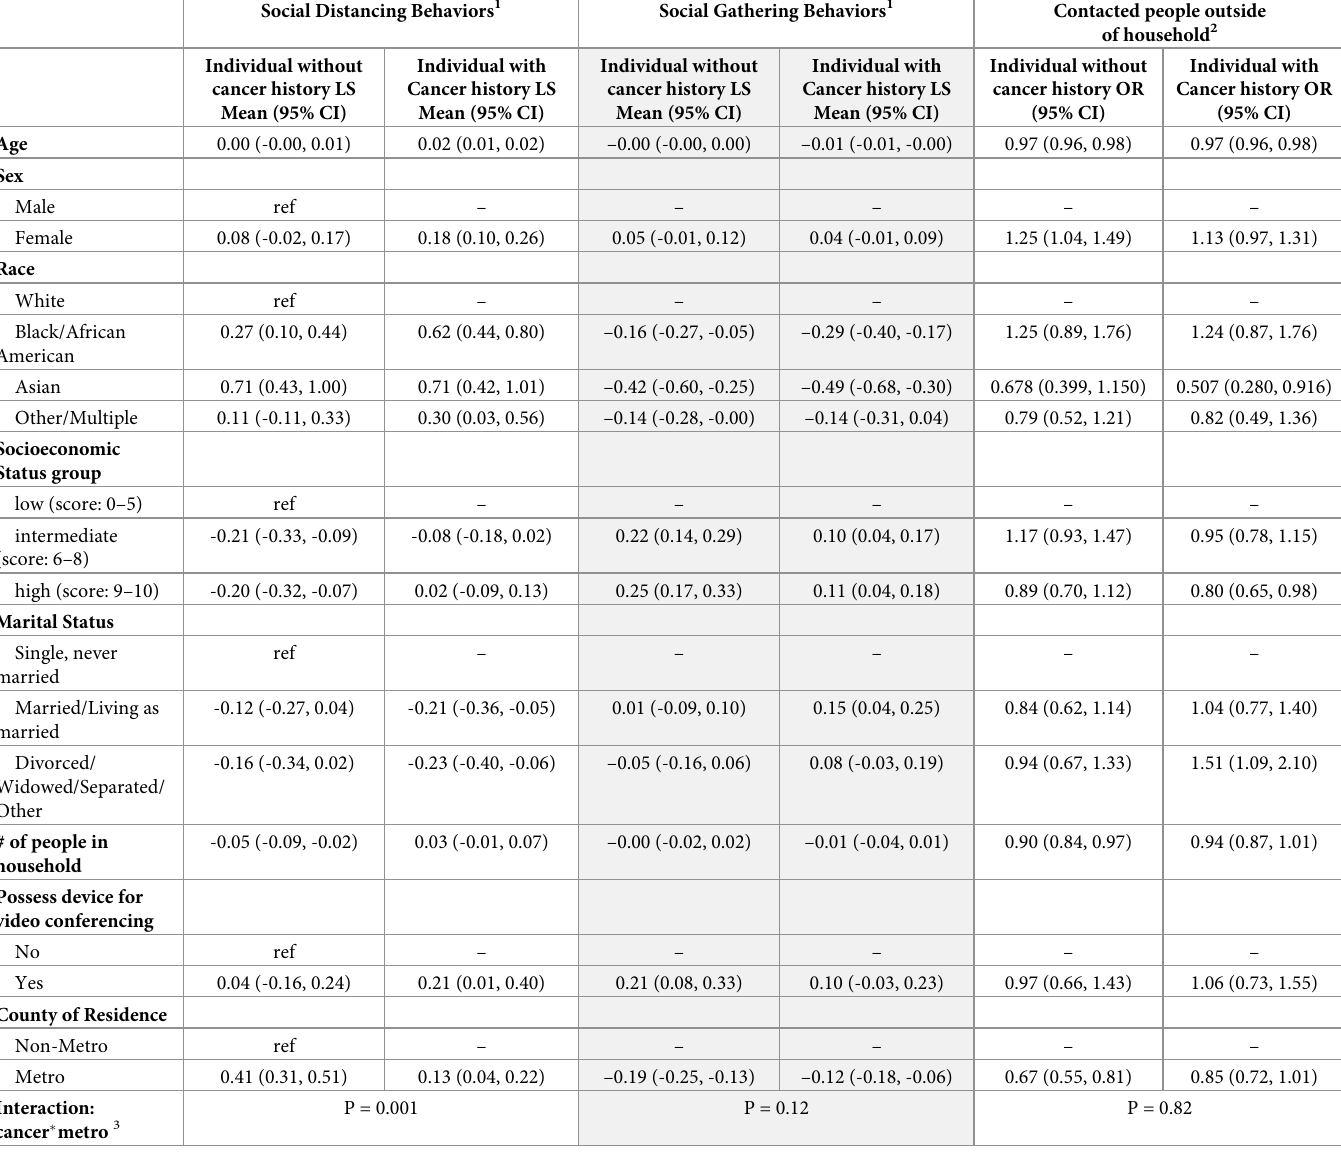
Table 3. Associations between metro residency and social distancing measures by cancer